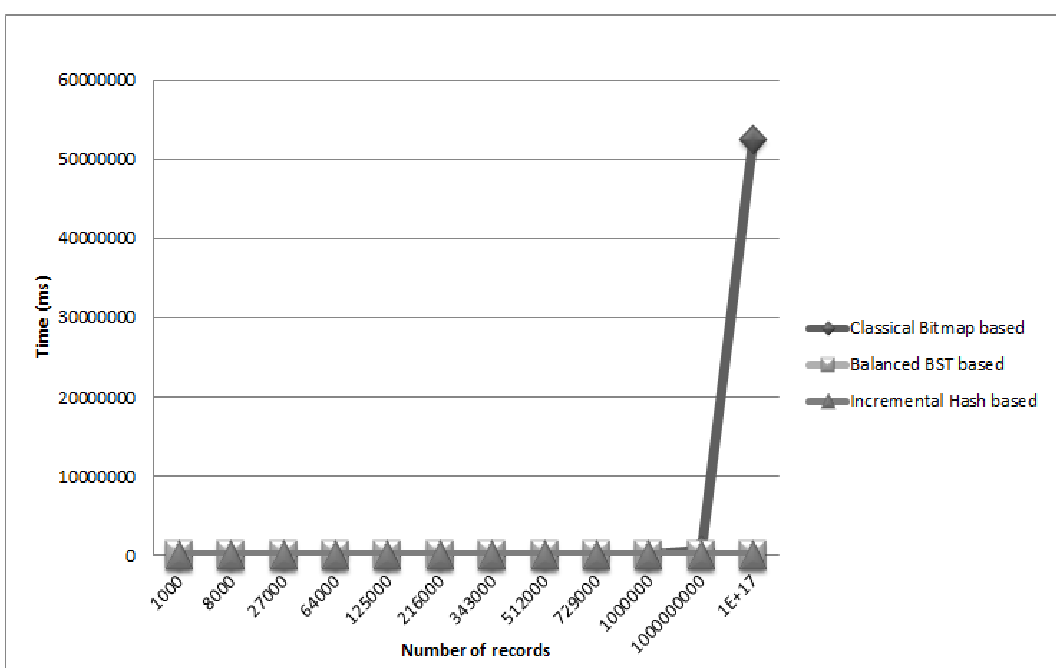
Figure 7. Running time